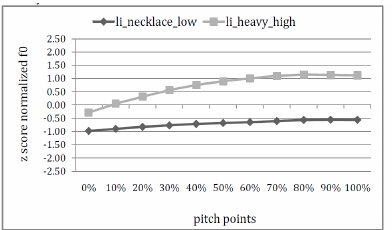
Figure 4: Normalized pitch contours for [li], (n=20{5 speakers*4 iterations